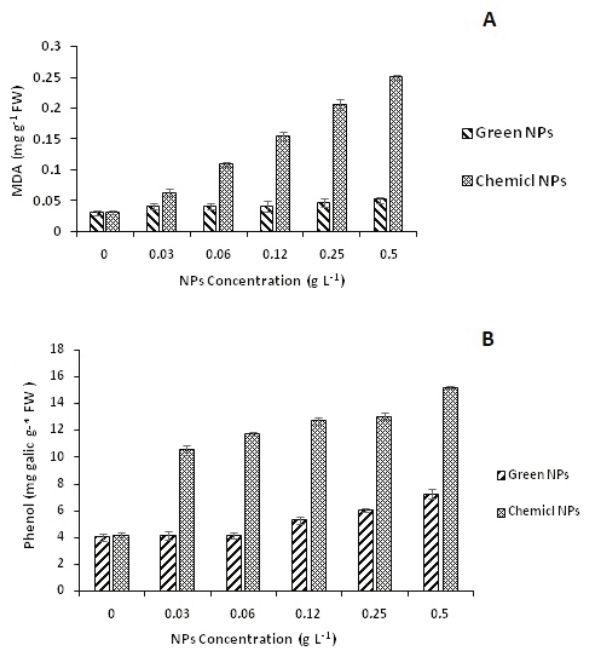
Fig. 8 ­ The influence of AgNPs type and concentration on MDA (A) and total phenol (B) in Allium cepa . Means ± SD of six replicates. The same letter denotes lack of a statistically significant difference (Tukey,